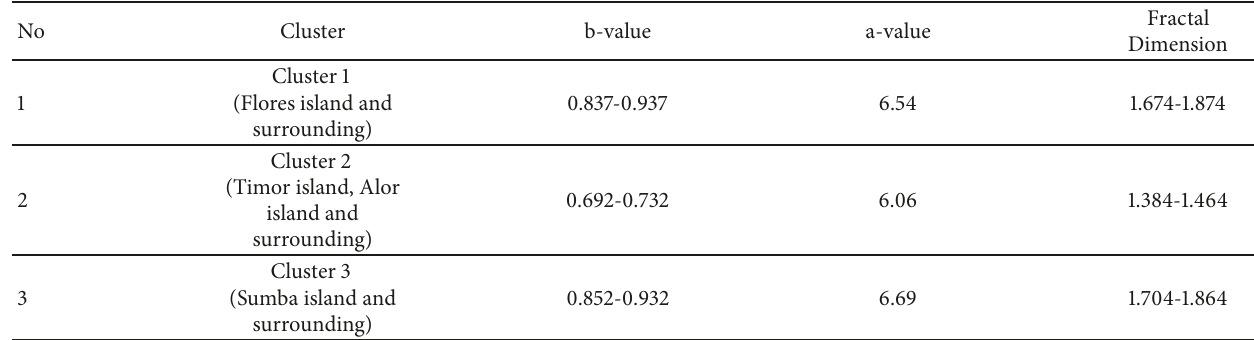
Table 1: The a-value and b-value and fractal dimension (D) of each